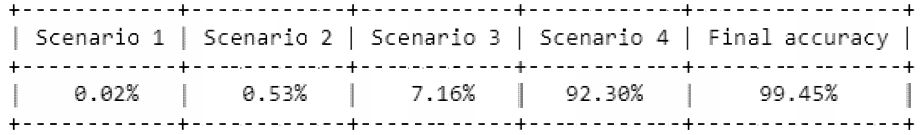
Figure 17. Experimental final accuracy for temperature data.